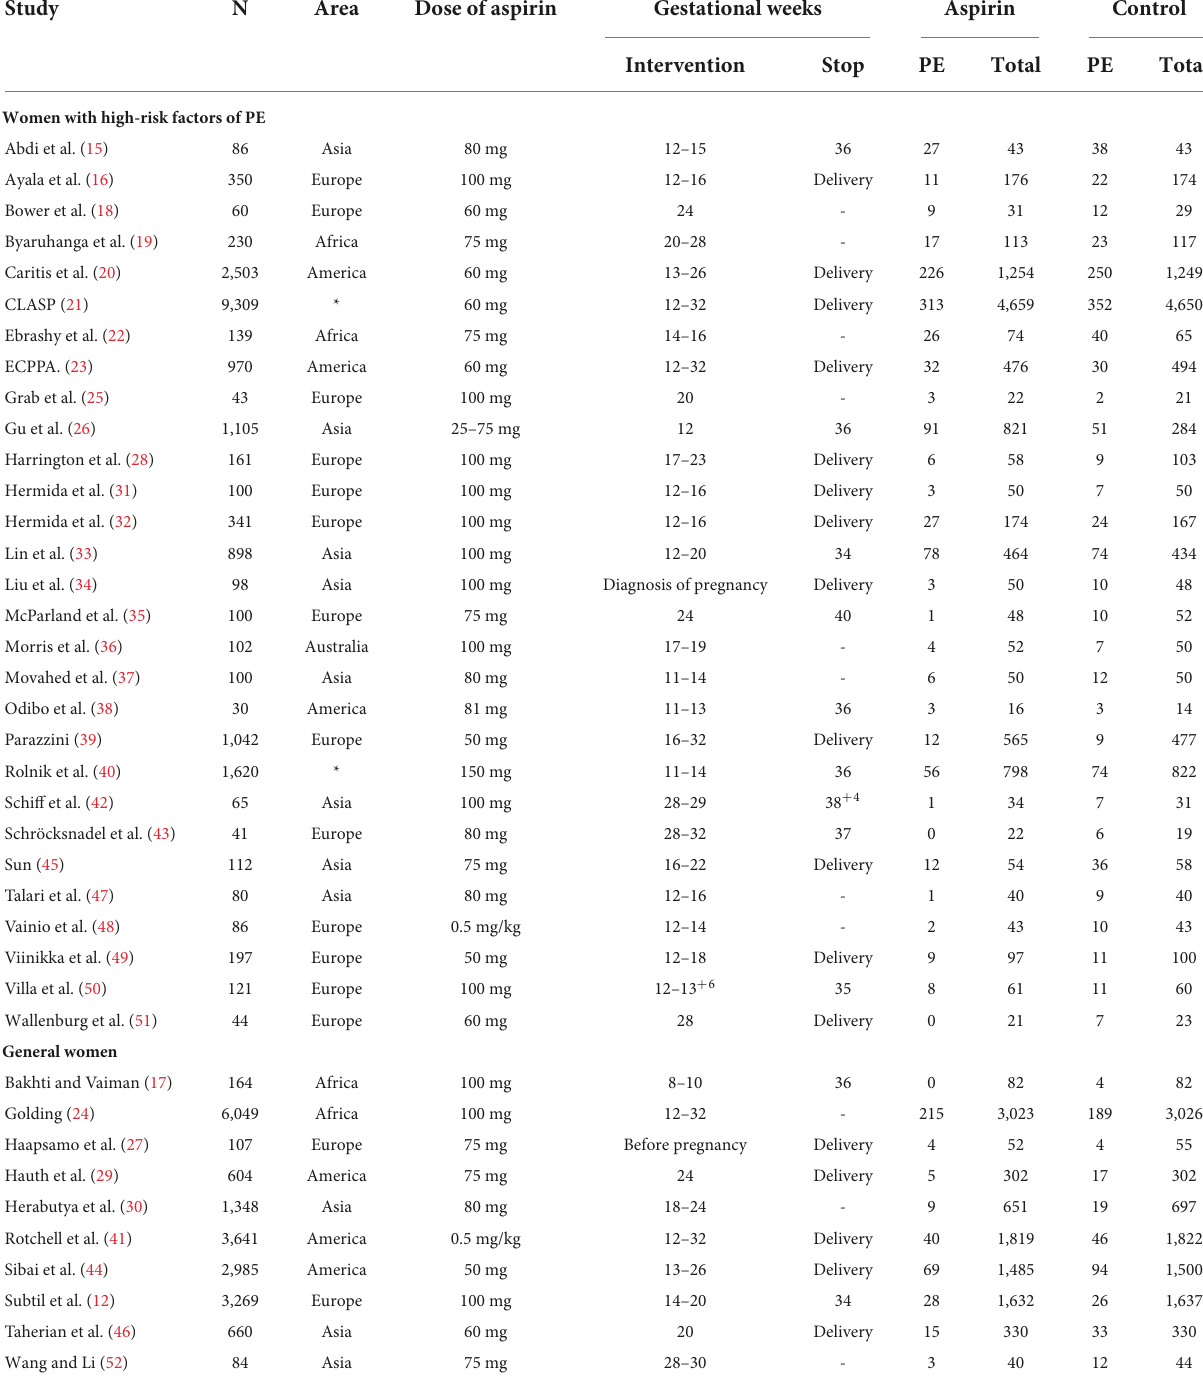
TABLE 1 Characteristics of the included